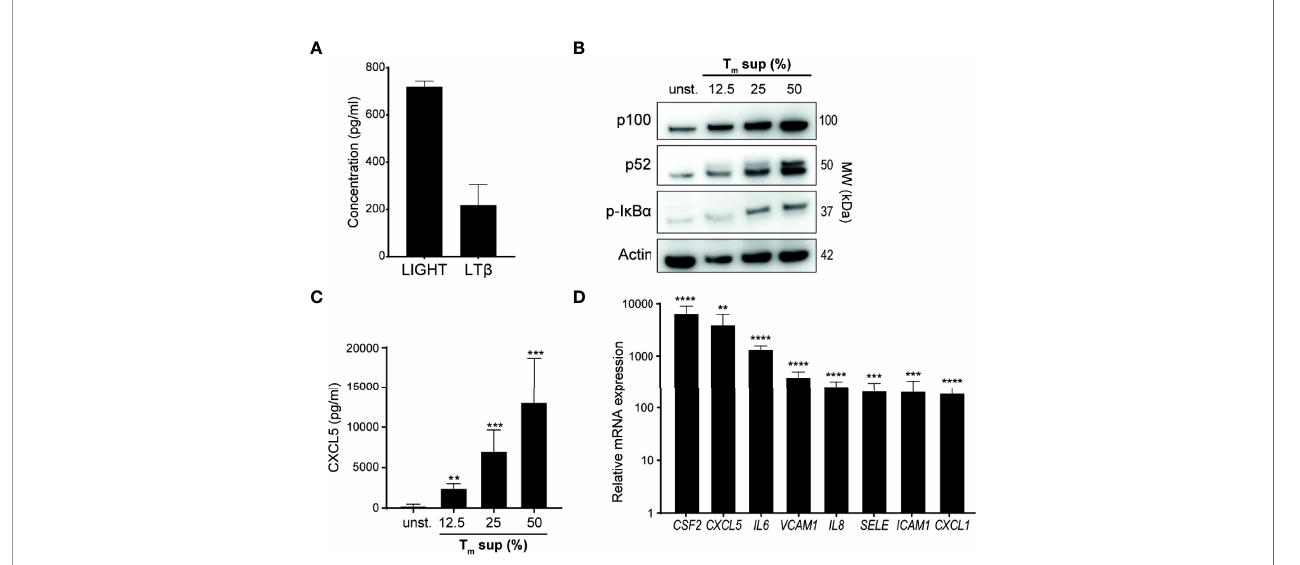
FIGURE 2 | Tm sup stimulation activates NF- k B signaling in ECs. (A) Quanti fi cation of LT b and LIGHT protein levels in pooled T m sup ( n= 5) by ELISA. Mean and SEM of experimental triplos is shown. (B-D) EC were stimulated with T m sup for 72h. (B) Representative western blot image of p100, p52 and p-I k B a expression in unstimulated (unst.) and stimulated ECs. Actin served as loading control. (C) ELISA quanti fi cation of CXCL5 protein production by ECs ( n= 6). Unstimulated ECs did not produce detectable levels of CXCL5 (not shown). (D) qPCR quanti fi cation of indicated mRNA transcripts in ECs stimulated with 50% T m sup ( n= 5). **p < 0.01, ***p < 0.001, ****p < 0.0001.